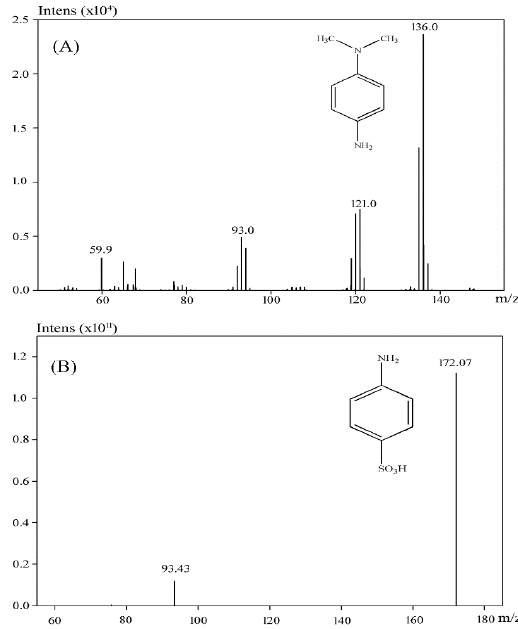
Figure 5. Identification of metabolites of Methyl Orange by GC-MS ( A ) and LC-MS ( B ) analysis. Int. J. Environ. Res. Public 2016 , 13 , 1053